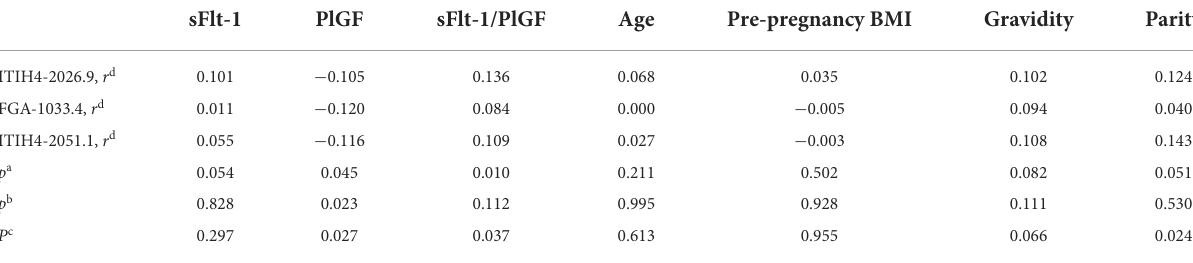
TABLE 4 Peptide candidates’ correlation analysis with clinical